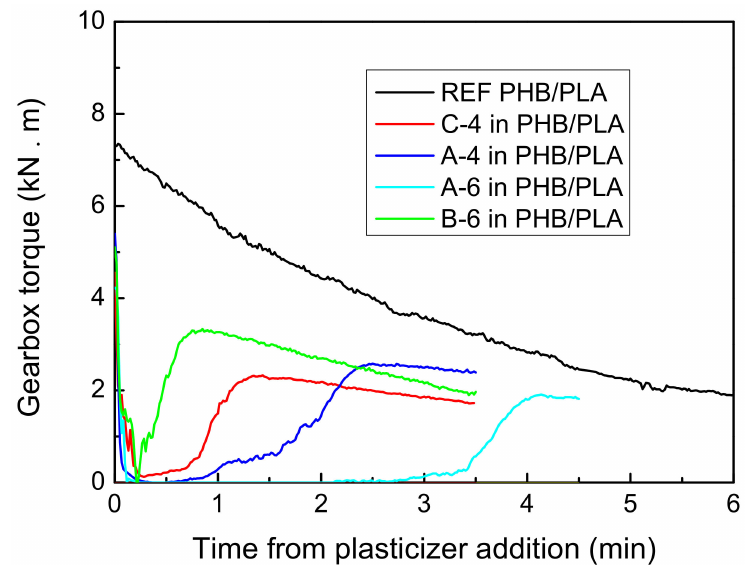
Figure 3. Gearbox torque dependence on the time elapsed from the addition of plasticizers to Poly(3-hydroxybutyrate/Poly(lactic acid) (PHB/PLA) mixture.